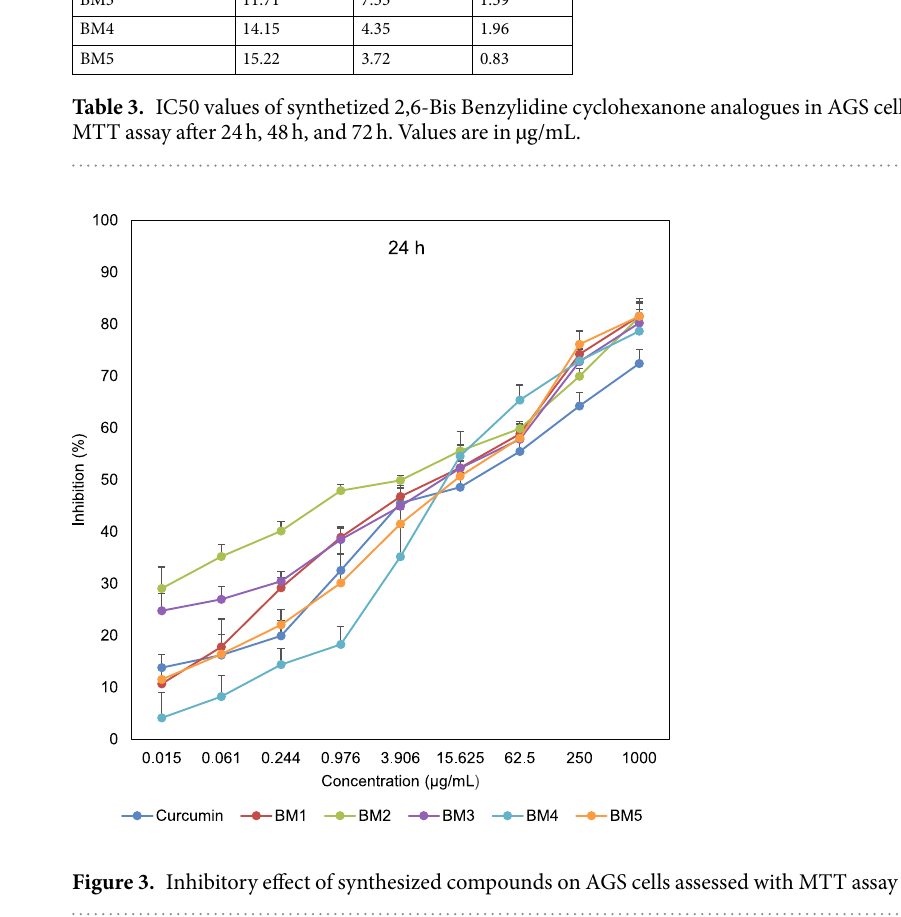
Figure 3. Inhibitory effect of synthesized compounds on AGS cells assessed with MTT assay at 24 h time